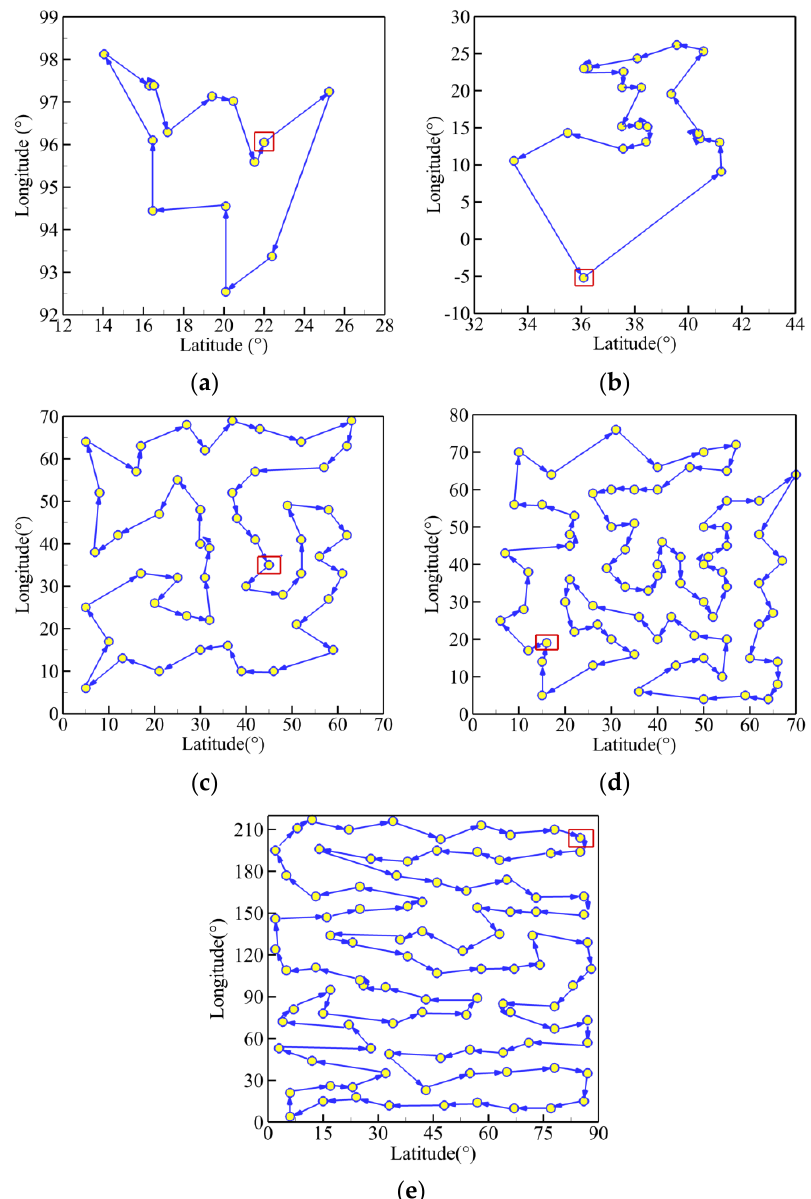
Figure 5. Best routes of five TSPLIB examples: ( a ) burma14; ( b ) ulysses22; ( c ) eil51; ( d ) eil76; ( e ) rat99.